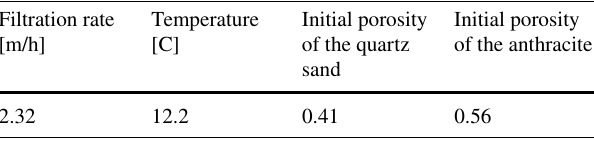
Table 2 Experimental parameters Filtration rate [m/h]